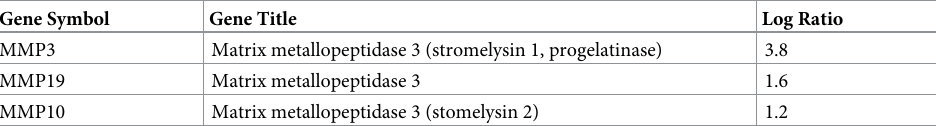
Table 1. Total RNA microarray based screening for the expression of MMPs with IL-1 β stimulation for 24 hours in mesenchymal stem